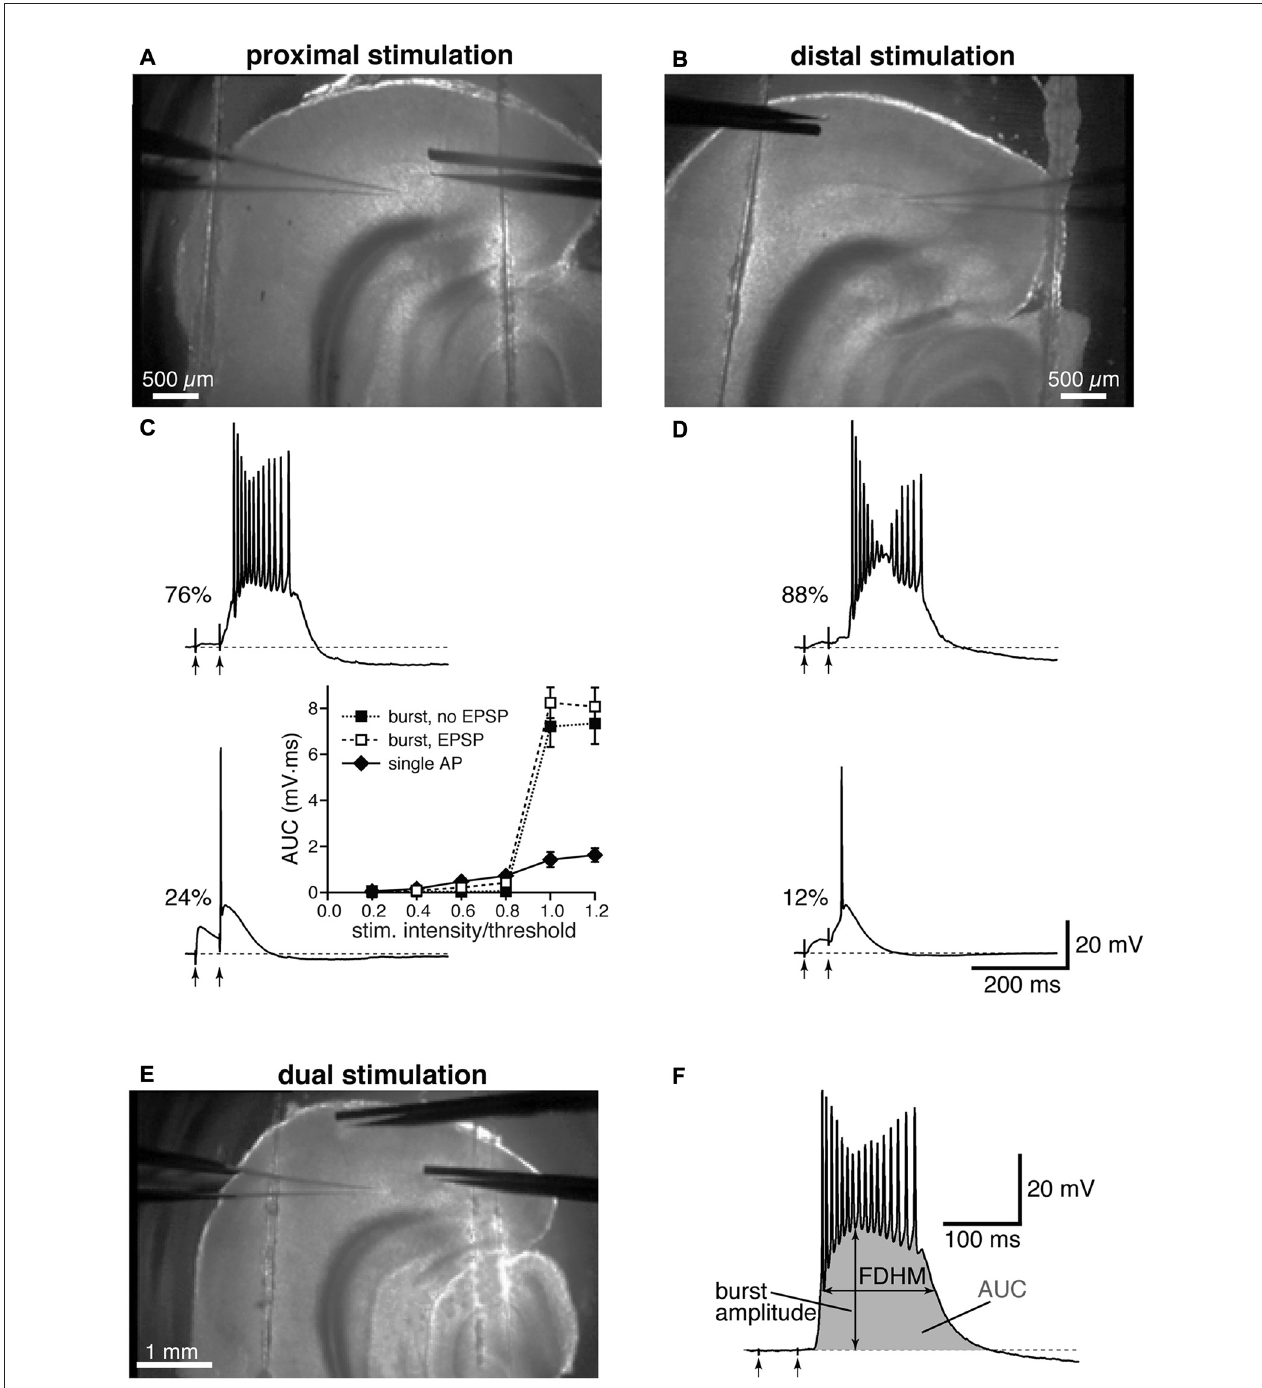
FIGURE 1 | Experimental configuration and analysis details. Top: low-magnification image showing the locations of stimulation and recording electrodes for proximal (A) and distal (B) electrical stimulation. Middle: the percentages of neurons firing a burst or a single action potential (AP) in the presence of gabazine (12.5 µ M) are reported next to example traces for proximal (C) and distal (D) stimulation. The arrows indicate the timing of the electrical stimulation. The inset in (C) shows average input-output curves for proximally-stimulated neurons which either showed burst firing without an appreciable subthreshold EPSP (filled squares), burst firing following an appreciable EPSP (open squares), or fired a single AP (filled diamonds; n = 5 per group). (E) Example of a dual stimulation experiment, in which the electrical stimulation of proximal and distal fibers was alternated. (F) Typical recording of a burst to demonstrate how the analysis was performed, with the full-duration at half-maximum (FDHM) quantified as the difference between the time points at which the membrane voltage reached half of the burst amplitude, and the area under the curve (AUC), shaded in gray, calculated as the integral of the depolarizing response.